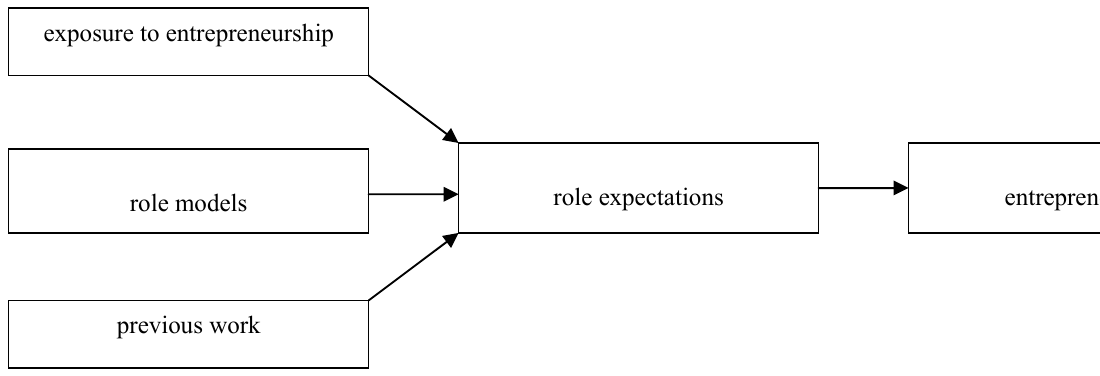
Figure 4: Diagram showing the relationship of role theory and entrepreneurship The same is true with entrepreneurship. The more the entrepreneur fulfils role expectations, the more likely the individual will be to succeed in that venture (Carsrud & Johnson, 1989). A number of researchers have reported that entrepreneurs have had previous experience in the industry in which they are starting their business. Prior work experience in the particular line of business is correlated positively with success (Vesper, 1982). Family and friends also seem to serve as role-models for aspiring entrepreneurs. Litvak and Maule (as cited by Shapero & Sokol, 1982) found successful high-technology entrepreneurs had fathers who were